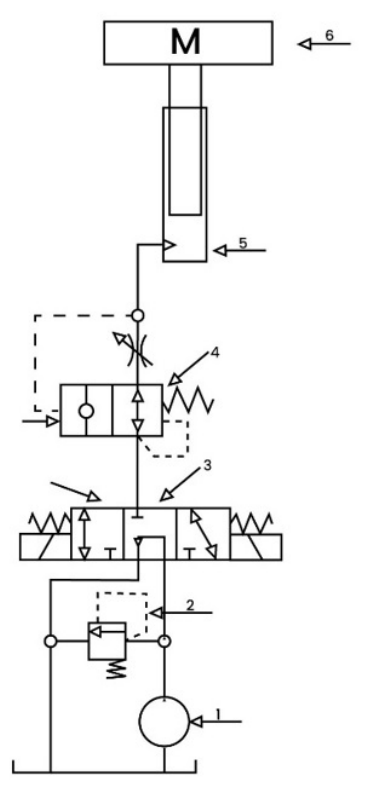
Figure 10. Schematic diagram of hydraulic